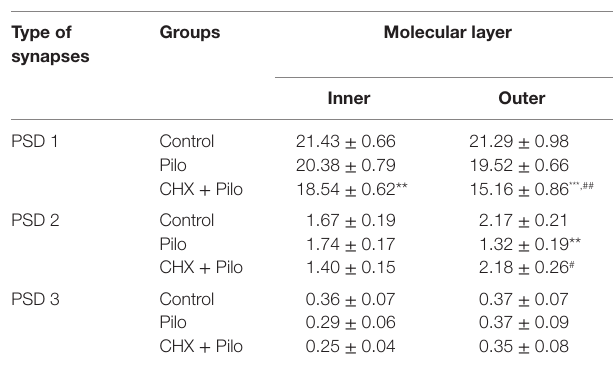
TaBle 1 | Mean number of asymmetric synaptic profiles per 100 μ m 2 in different layers of the dentate gyrus.